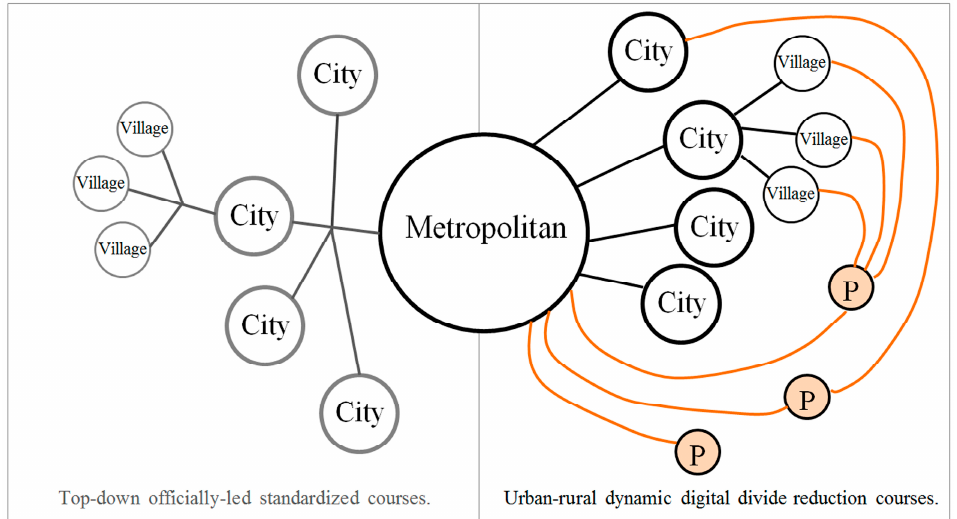
Figure 4. Comparison of a top-down standardized course (left site) and PunCar Action’s approach to bridging the digital divide (right site). P stands for PunCar